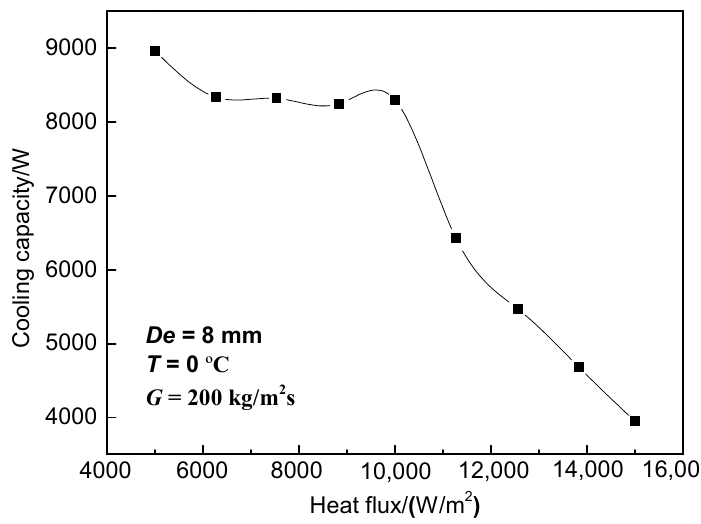
Figure 7. E ff ect of heat flux on cooling